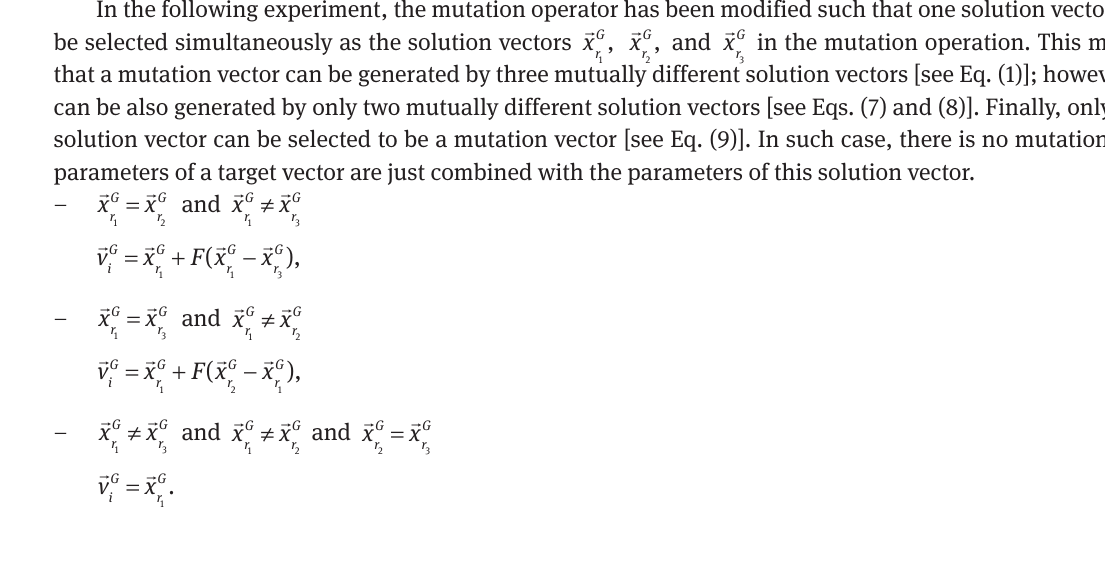
In the case of Eqs. (7) and (8), two arcs would lead from the node representing a target vector G (cid:31) representing a solution vector . G x In the case of Eq. (9), even three arcs would lead from the node represent- r (cid:31) 1 ing a target vector G to the node representing a solution vector x i weighted arc. This means that in the case of Eqs. (7) and (8), the weight of the arc leading from the node rep- (cid:31) G resenting a target vector to the node representing a solution vector x r 1 of Eq. (9), the weight of the arc leading from the node representing a target vector G (cid:31) G a solution vector will be three. At the end of each generation, each individual will remember the strength x r 1 of the node, which represents this individual in the LSN, and in the next generation, for each target vector, three solution vectors are selected on the basis of the node strength. A higher node strength means a higher probability to be selected for the mutation